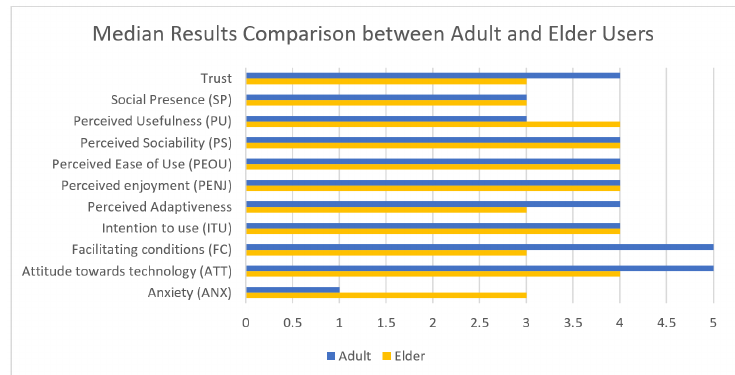
Figure 9. Median Results Comparison between Adult and Elderly